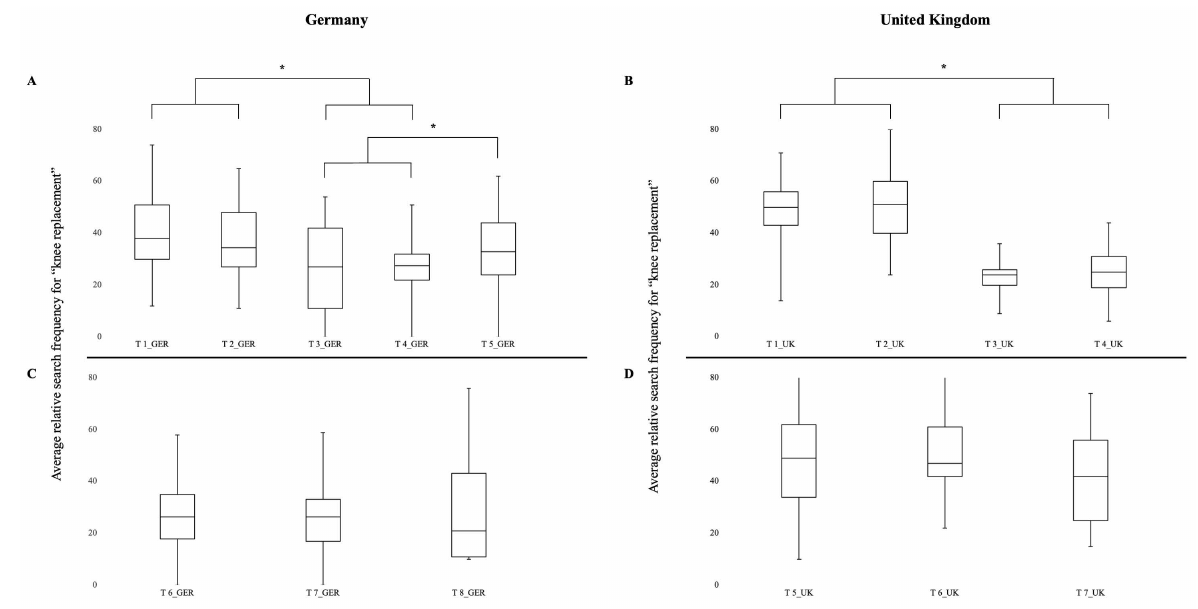
Figure 3. Comparison of mean search frequencies for knee arthroplasty. ( A , B ) First half of 2020. Mean search frequencies were calculated from January 1 till the first confirmed SARS-CoV-2 case (T1_GER and T1_UK), till the first panic buying (T2_GER and T2_UK), till the lockdown (T3_GER and T3_UK), till the end of the lockdown (T4_GER and T4_UK), and till the end of the 2nd half of the year (T5_GER). ( C , D ) Second half of 2020. Mean search frequencies were calculated till the start of the lockdown light in Germany (T6_GER), till the start of the second lockdown (T7_GER and T5_UK), and till the end of 2020 (T8_GER and T6_UK). * p < Figure 4. ( A ) Relative patient numbers (black curve) referred to our outpatient department and number of new SARS-CoV-2 infections (grey, striped area). ( B ) Percentage of patients with knee osteoarthritis to assess clinical indications for primary knee replacement in our outpatient department.